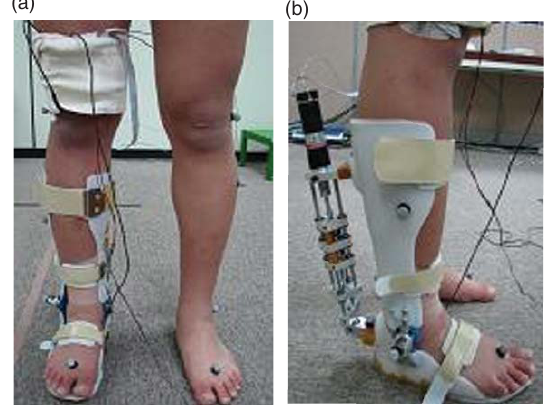
Fig. 7. Gait analysis: NAFO, HAFO, and AAFO.